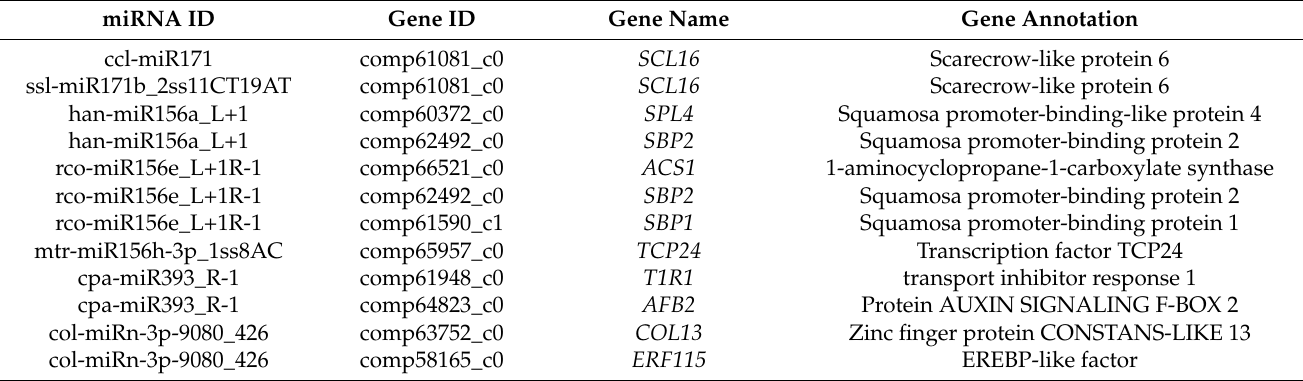
Table 3. Predicted miRNAs and their target genes involved in growth and